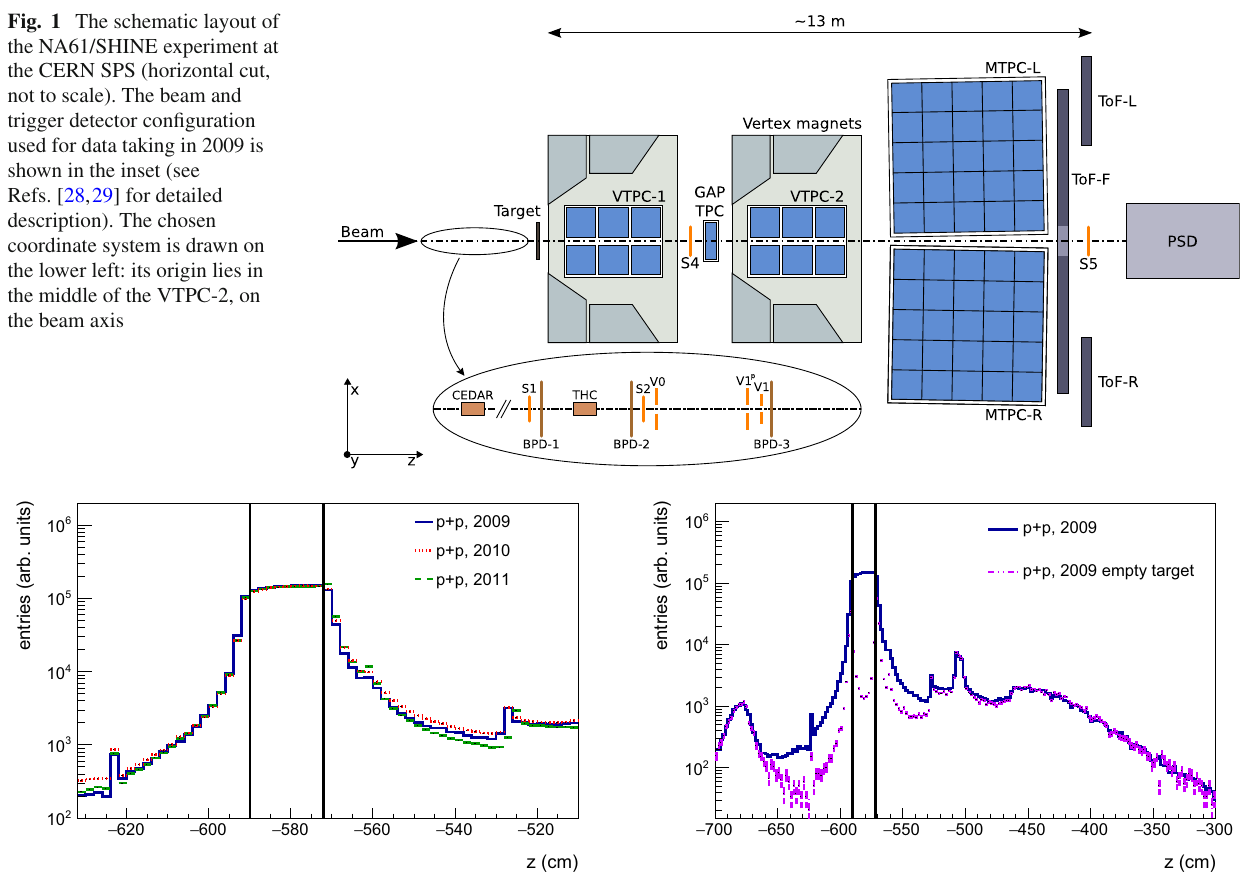
Fig. 2 Left:distributionsofthe z -coordinateofthereconstructedinter- action vertex ( z ) for events recorded with the target inserted (2009, 2010 and 2011 data). Histograms are normalized to the same integral in the range − 590 < z < − 572 cm. Right: distributions of the z - coordinate of the reconstructed interaction vertex for target-inserted